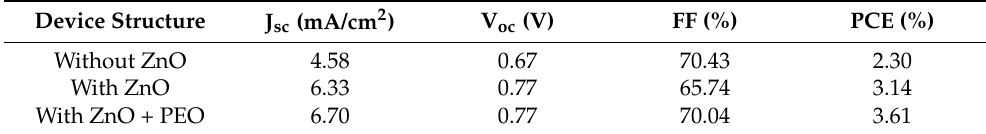
Table 2. Device’s parameters such as short circuit current density (J sc ), open circuit voltage (V oc ), fill factor (FF), and power conversion efficiency (PCE) without electron transport buffer layer and with electron transport buffer layer of ZnO (or